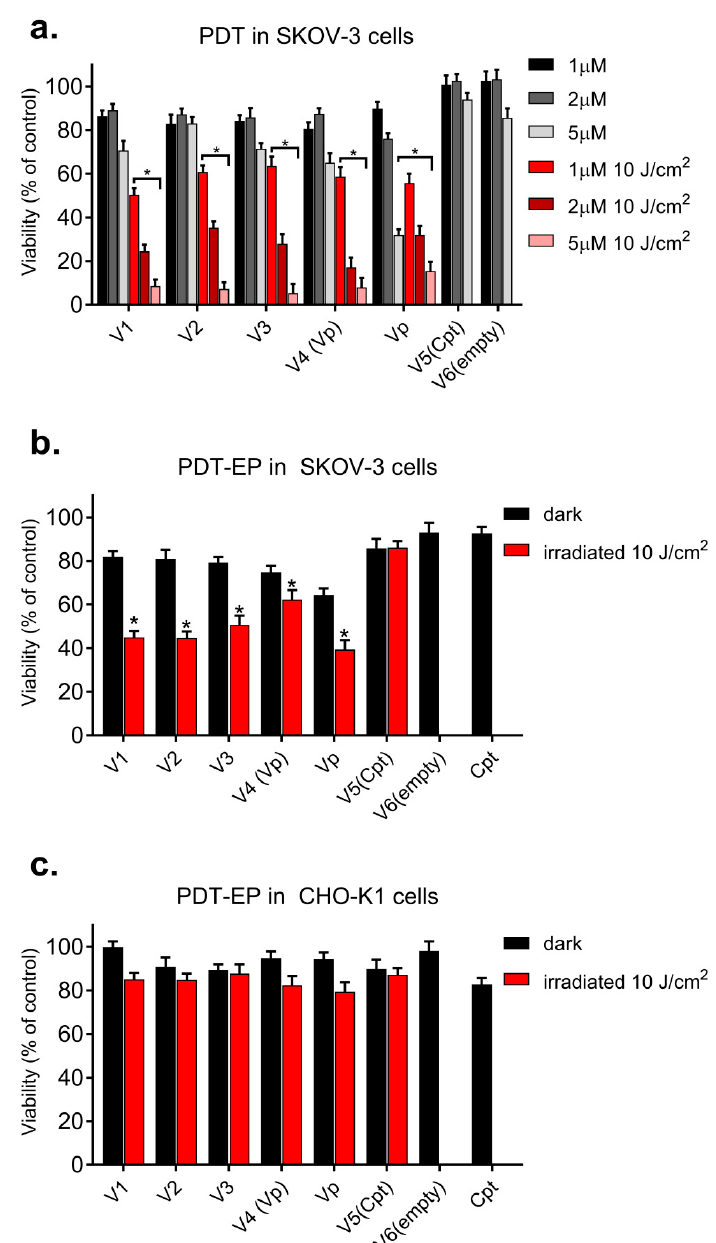
Figure 6. Photodynamic treatment (PDT) in SKOV-3 after 24 h of incubation with NCs ( a ) and photodynamic reaction facilitated by EP after 10 min exposition to nanosystems ( C VP = 1 µM) in SKOV-3 ( b ) and CHO-K1 ( c ) cells. The missing red bars for V6 and free Cpt represent non irradiated negative controls. See description of the NCs in Table 1. Data represented as means ± SD for minimum n = 3, where * p ≤ 0.05 was judged as statistically significant.